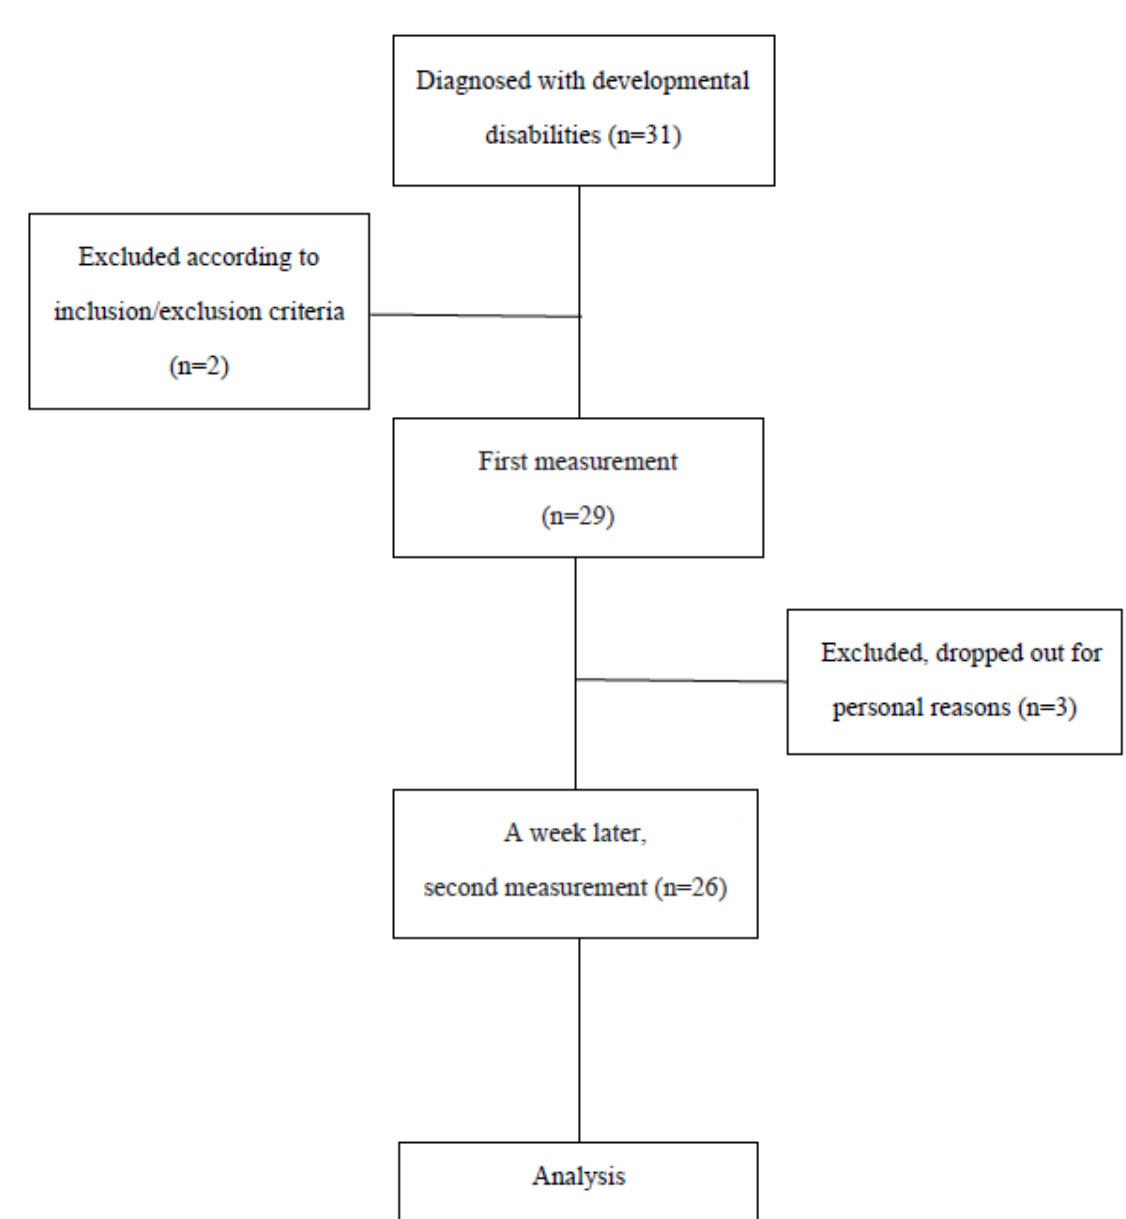
Figure 1. Flowchart of the study.